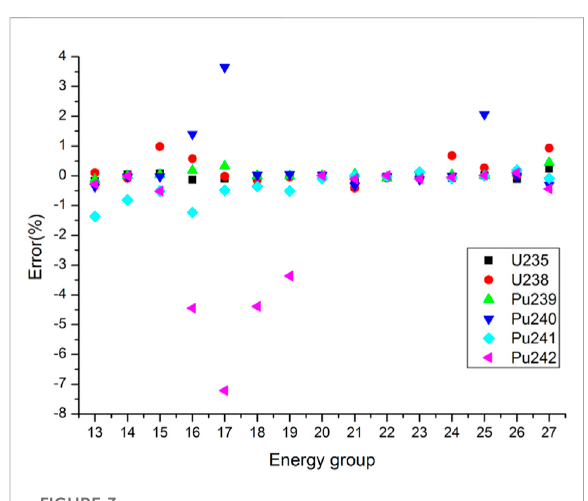
FIGURE 3 Comparison of resonant nuclides ’ absorption cross